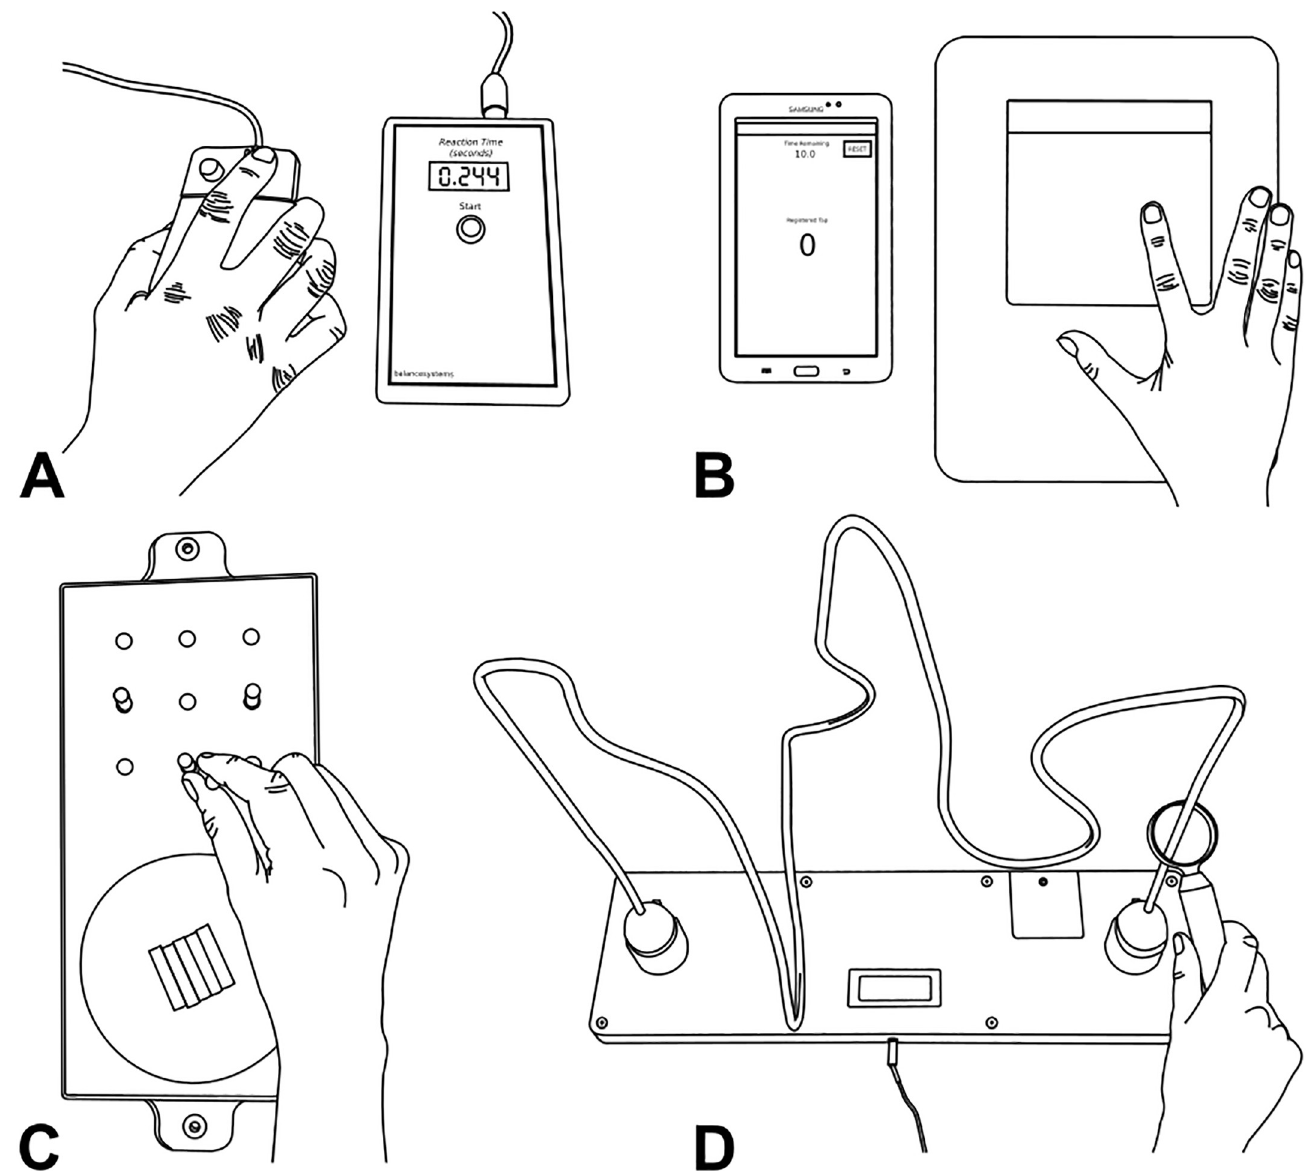
Fig 3. Tests of unilateral movement and dexterity. (A) Finger-press reaction time. The participant pressed the right button as soon as the emitting red light stimulus (embedded in the left button of the mouse) was illuminated. (B) Finger tapping. The participant tapped their dominant index finger up and down onto the tapping sensor as many times as they could over a 10s period. (C) 9-hole peg test. The participant picked up one peg at a time from the moulded dish and placed them into any of the nine holes behind the dish, before individually returning each peg back to the moulded dish as quickly as they could. (D) Loop and wire test. The participant held the handle attached to the ring and attempted to move the ring through the copper wire maze as fast and as accurately as possible. Two trials were completed, one in each